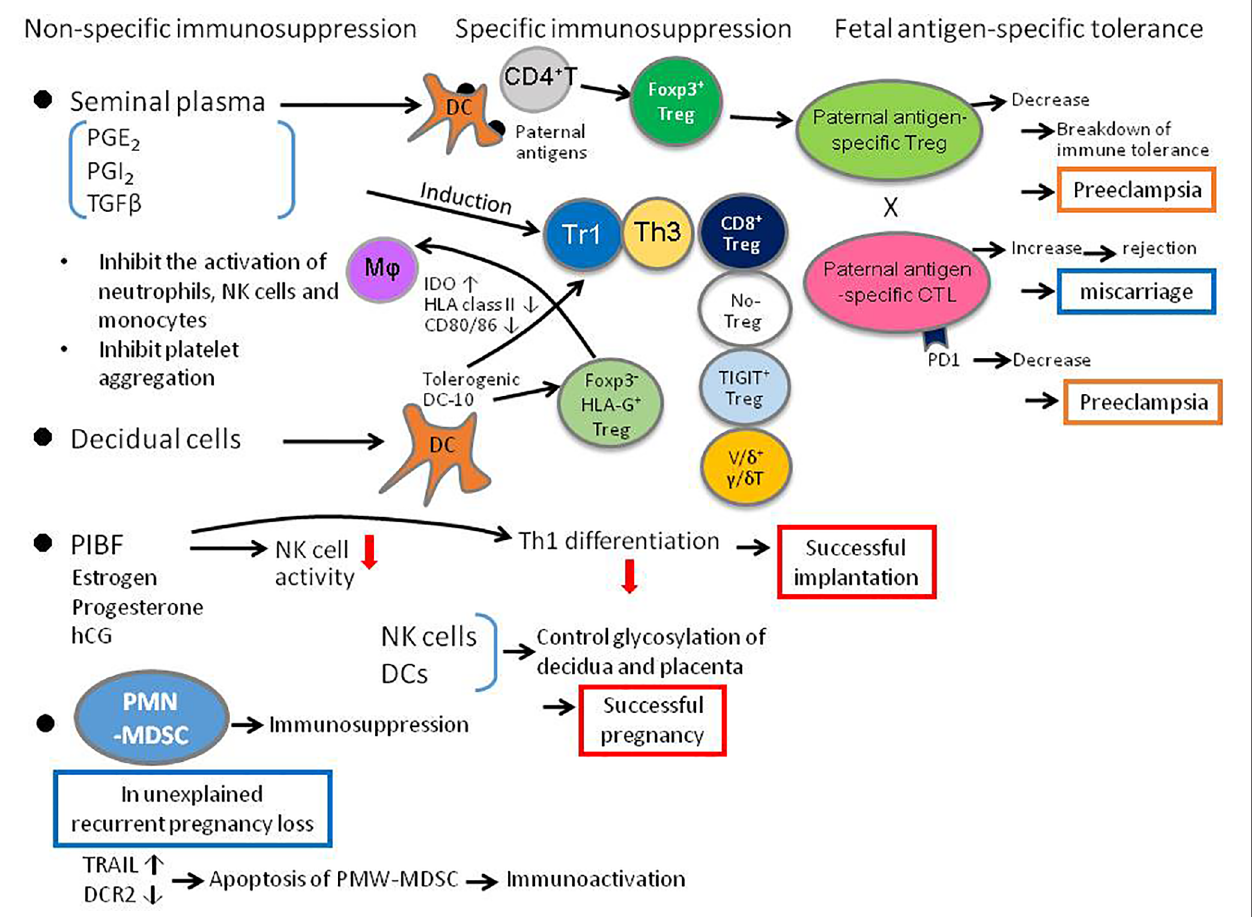
FIGURE 1 | Diagrammatic summary of critical elements of the adaptive immune response to pregnancy, that determine the balance between T cell tolerance and T effector function, and in fl uence the outcome of pregnancy and infant health. DC, dendritic cell; IDO, indoleamine-dioxygenase; M F , macrophage, PD1, programmed death 1; PIBF, pregnancy-induced blocking factor; PMN-MDSC, polymorphonuclear myeloid-derived suppressor cell; PGE, prostaglandin E2; PGI, prostaglandin I: Tr1, T regulatory 1; Th, T helper; TIGIT, T cell immunoglobulin and ITIM domain; Treg, regulatory T cell; uNK, uterine natural killer